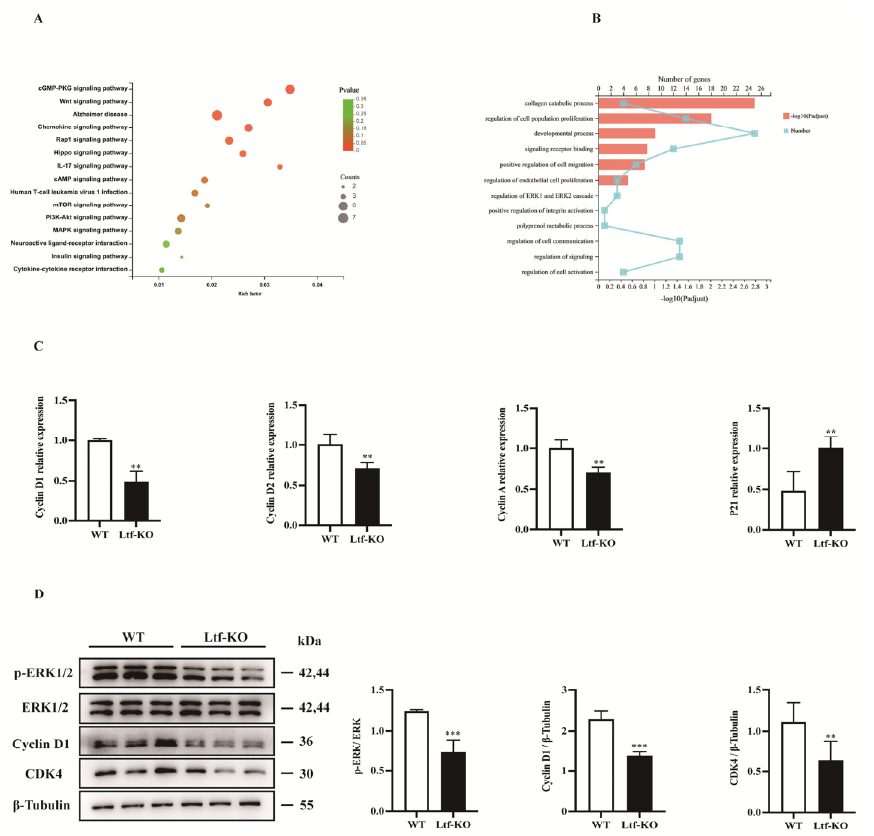
Figure 3. Decreased proliferation of SCs caused by Ltf deficiency is regulated by the ERK1/2 signaling pathway. ( A ) KEGG pathway enrichment analysis was performed on SCs from WT and Ltf -KO mice grown for 4 days in vitro. ( B ) GO enrichment analysis was performed on SCs from WT and Ltf -KO mice grown for 4 days in vitro. ( C ) Fluorescence quantitative analysis of the expression of cell cycle-related genes in SCs from WT and Ltf -KO mice grown for 4 days in vitro, using actin as an internal reference. ( D ) Left, the immunoblots presented here illustrate the protein levels of p-ERK, ERK, cyclin D, CDK4 and β -tubulin in SCs from WT and Ltf -KO mice grown for 4 days in vitro; right, quantification analysis of p-ERK, cyclin D1 and CDK4 proteins levels from Western blot bands. β -tubulin was used as an internal reference. n = 3 in each group. ** p < 0.01; *** p < 0.001.